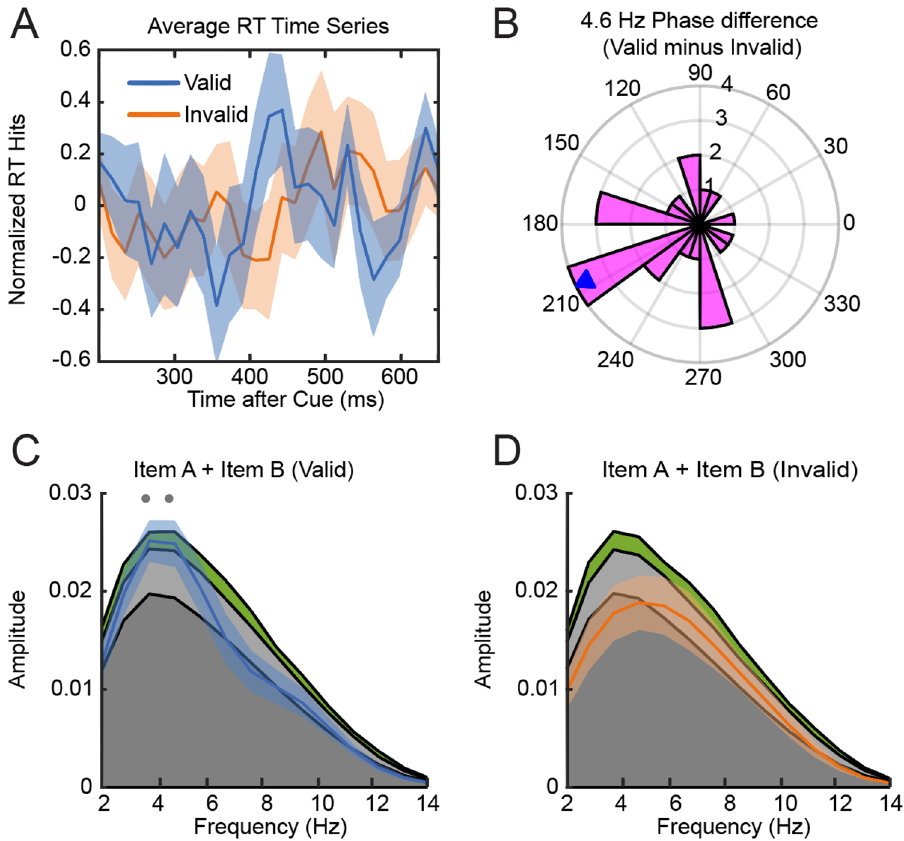
Figure 3. ( A ) Group average RT time series for valid and invalid trials. ( B ) 4.6 Hz Phase difference plot. ( C ) Power-spectrum RT time series valid condition. Colored areas in the background display quantiles of statistical null distribution (dark grey: Mean of permutation distribution, light grey: Power < 95% confidence interval, green: Power < 99% confidence interval). Dots indicate frequencies at which observed spectrum exceeded 95% of samples from permutation distribution (gray: significant before correction for multiple comparisons, black: significant after correction of multiple comparisons). ( D ) same as C but RT time series of Invalid